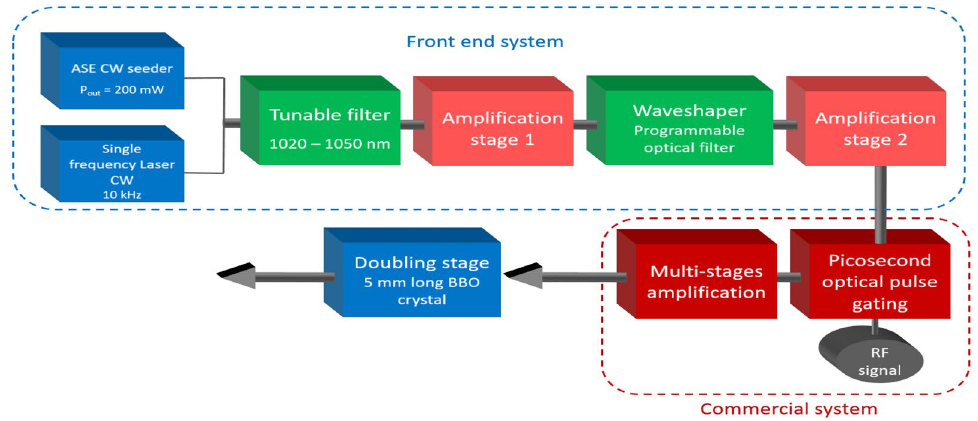
Figure 3. Experimental set-up of the pulsed ASE system delivering up to 20 W of average